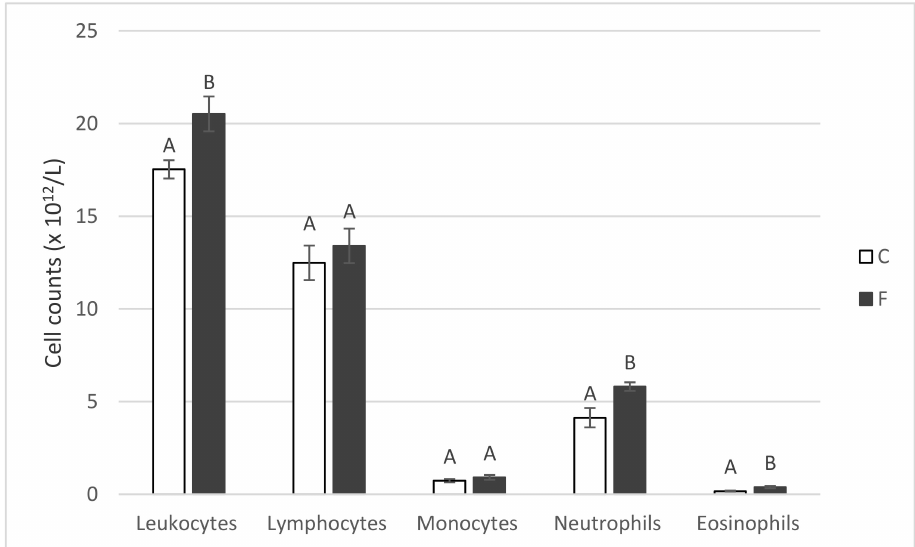
Figure 3. Selected hematological parameters of pigs fed for four weeks on either the control standard feed mixture (C) or feed mixture enriched with 8% fish oil (F). Means with di ff erent letters within the given parameter di ff er at p < 0.05 (Mann–Whitney U test; n =